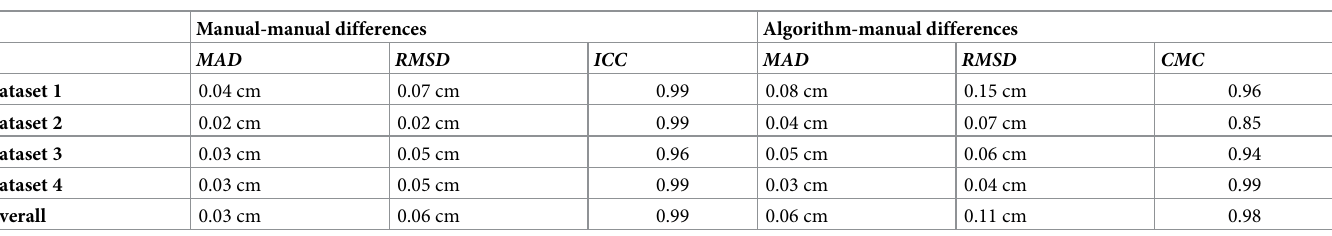
Table 1. Muscle thickness. Manual-manual differences Algorithm-manual differences